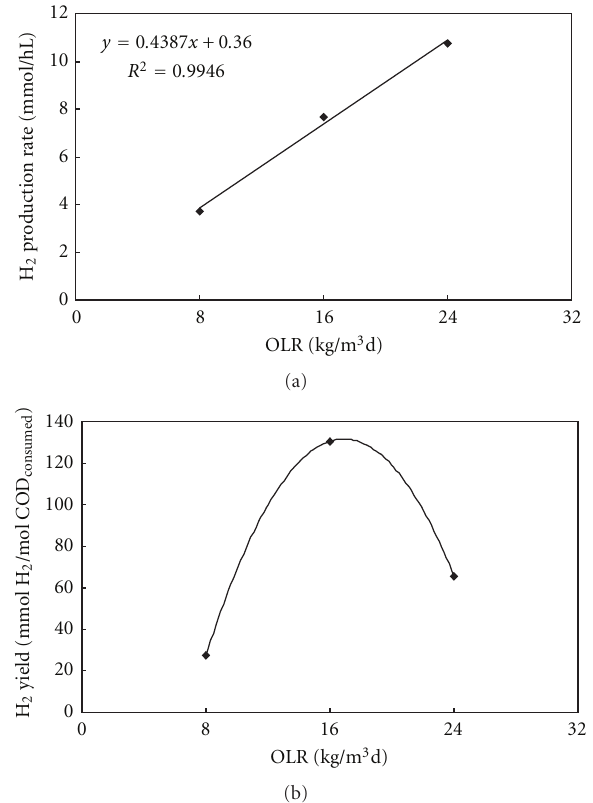
Figure 3: The performance of hydrogen production at di ff erent OLRs in the